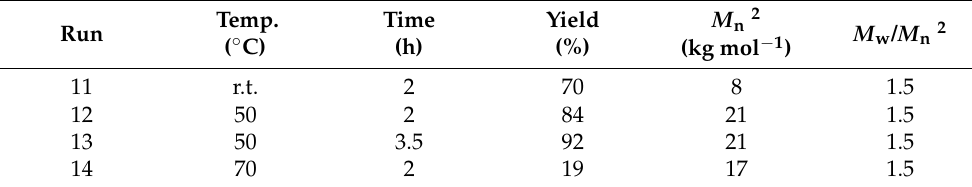
Table 3. Synthesis of Poly(GBGA) 1